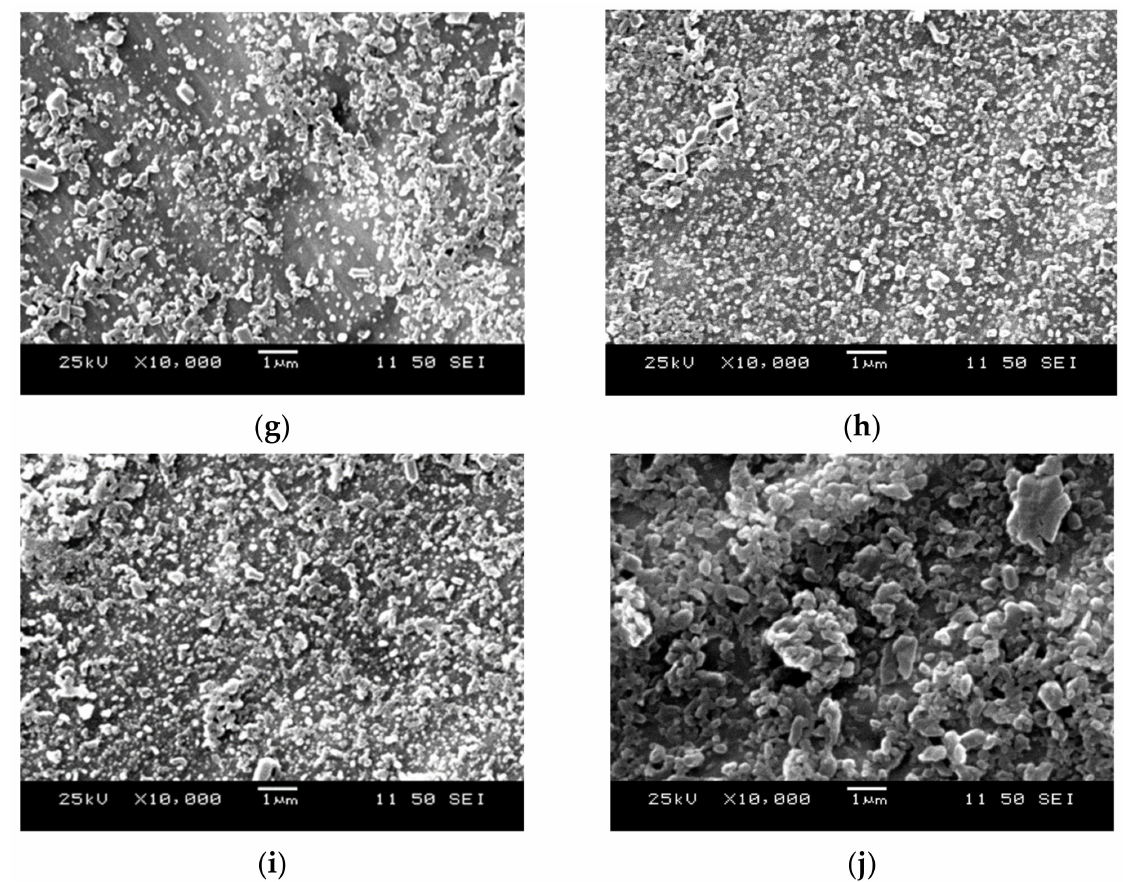
Figure 2. Morphology of MFA particles in each sample immediately after preparation: ( a ) MFA crystals, ( b ) Pontal Syrup ® , ( c ) MFA+0.5 w / v % HPC-SSL suspension (F1), ( d ) MFA+0.5 w / v % HPC-SL suspension (F2), ( e ) MFA+0.5 w / v % HPC-L suspension (F3), ( f ) MFA+0.5 w / v % HPC-SSL+0.12 w / v % SDS suspension (F4), ( g ) MFA+0.5 w / v % HPC-SL+0.12 w / v % SDS suspension F5, ( h ) MFA+0.5 w / v % HPC-L+0.12 w / v % SDS suspension (F6), ( i ) MFA+1.0 w / v % HPC-SL+0.12 w / v % SDS suspension (F7), ( j ) MFA+2.0 w / v % HPC-SL+0.12 w / v % SDS suspension